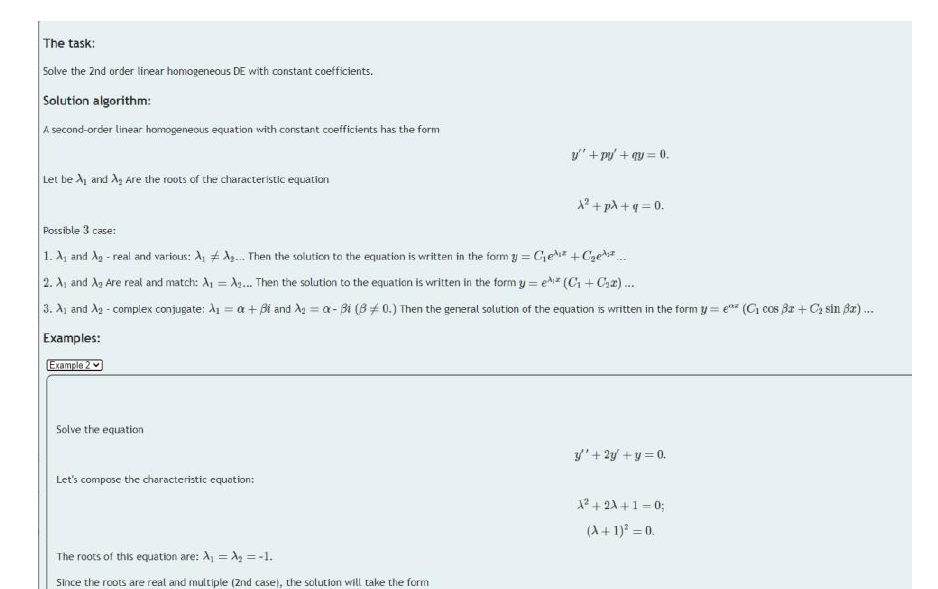
Fig. 4. An example of a problem for a seminar.